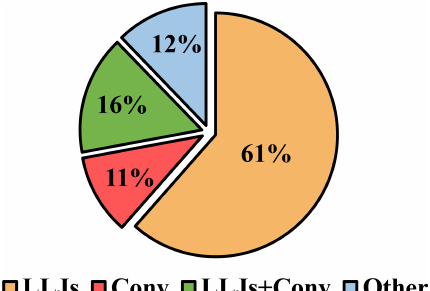
Figure 2. The average relative contribution of different meteoro- logical processes to NOI events during